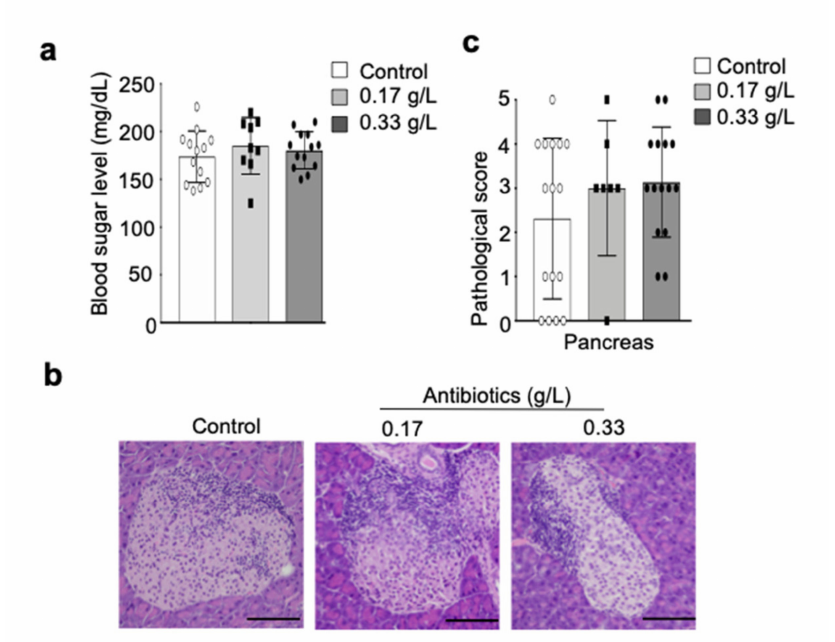
Figure 5. Effect of antibiotic administration on autoimmune diabetes in NOD mice. ( a ) Blood glucose concentration in control and antibiotic-administered (0.17 and 0.33 g/L) mice were determined by blood glucose meter. Data are presented as mean ± SD of 13 mice in control and 0.33 g/L groups and 9 mice in the 0.17 g/L group. ( b ) Pathological photos of pancreas tissue sections stained with H&E are shown, and the results are representative of 16 mice in control group and 7 mice in 0.17 g/L group, and 15 mice in 0.33 g/L group. Scale bar: 100 µ m. ( c ) Pathological score of pancreas tissues was evaluated, and data are presented as mean pathological score ± SD of 16 mice in control group, 7 mice in the 0.17 g/L group, and 15 mice in the 0.33 g/L